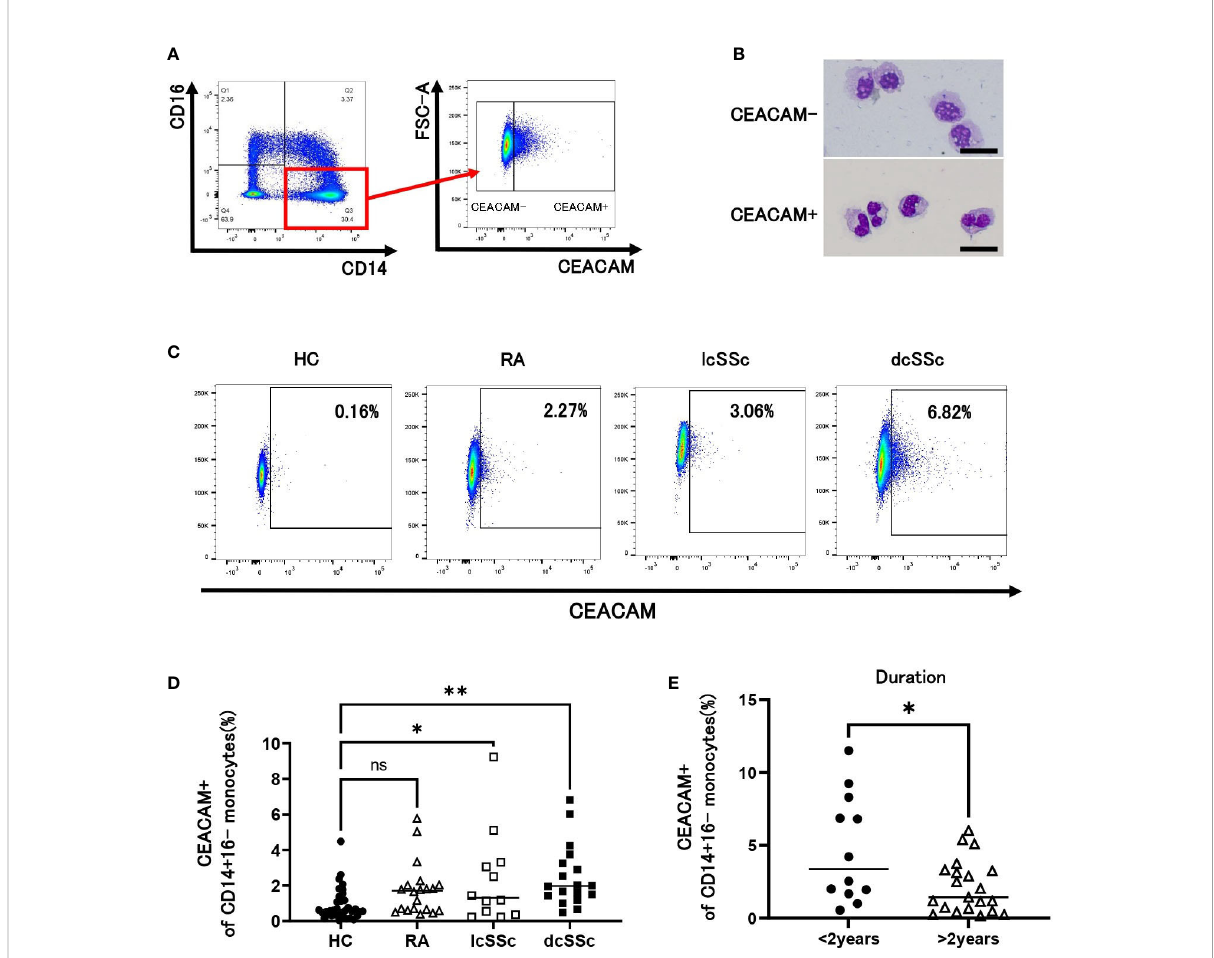
FIGURE 1 CEACAM expression on CD14+16- classical monocytes. (A) Gating strategy for identi fi cation of CEACAM+CD14+16- classical monocytes using fl ow cytometry. (B) Giemsa staining for CEACAM-negative (CEACAM-) and CEACAM-positive (CEACAM+) classical monocytes. Sorted CEACAM- and CEACAM+ cells were stained with May-Grünwald Giemsa after cytospin centrifugation. Scale bar represents 20 µm. (C, D) CEACAM staining for classical monocytes identi fi ed using fl ow cytometry. Dot plots show CEACAM staining gated on CD14+16- cells from healthy controls (HCs) (n = 34) and patients with rheumatoid arthritis (RA) (n = 20), limited cutaneous systemic sclerosis (lcSSc) (n=12), and diffuse cutaneous systemic sclerosis (dcSSc) (n = 18) analyzed using fl ow cytometry. Representative data for each group are shown (C) . The proportion of CEACAM+ cells in classical monocytes is plotted (D) . (E) The proportion of CEACAM+CD14+16- monocytes was compared between patients with SSc within 2 years after diagnosis (< 2 years) and those with SSc over 2 years after diagnosis (> 2 years). P values were calculated using one-way ANOVA with Tukey ’ s-multiple comparisons testing between all groups (D) and Mann – Whitney U test (E) . * P < 0.05, ** P <